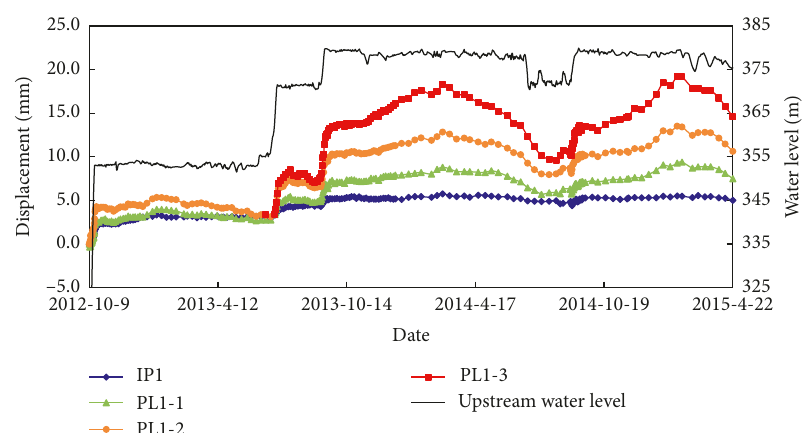
Figure 5: Measured displacements of the #7 left-bank water-retaining dam section.